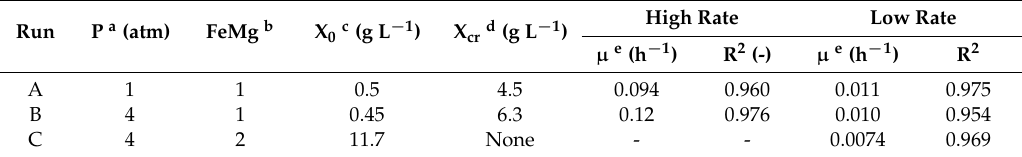
Figure 4. ( A ) Chemolithotrophic growth of C. necator under two gas pressures (1 atm and 4 atm). See Table 2 for the fermentation conditions and concentrations of Fe and Mg. The amounts of Fe and Mg were doubled in one fermentation (4atm_FeMg). ( B ) Logarithm of cell density ratio ( X / X 0 ) versus time under two gas pressures (1 atm and 4 atm). X 0 is the initial cell density. Table 2. Effect of gas pressure on cell growth rate.